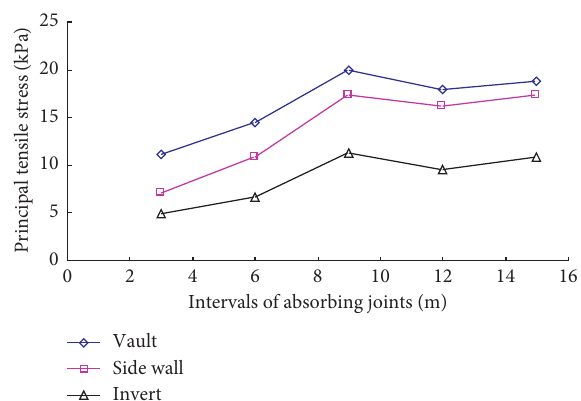
Figure 12: Relationship between principal tensile stress and in- terval of absorbing